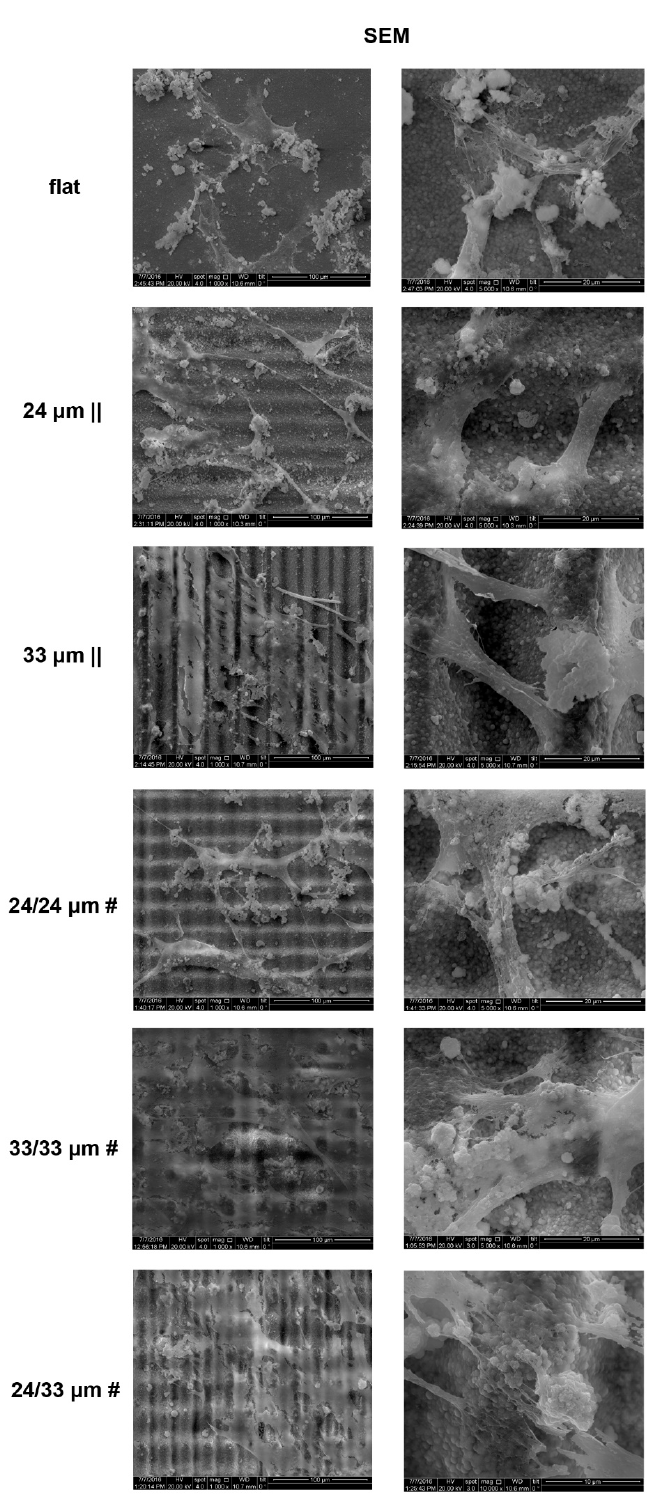
Figure 8. Cell morphology analysis upon osteogenic di ff erentiation of human mesenchymal stem cells (hMSCs) onto Zirconia microtopographies. Scanning electron microscopy (SEM) images of cells cultured for 28 days on Zirconia bio-interfaces in osteoinductive media conditions. Low- and high-magnification SEM images are presented representing each of the structured Zirconia